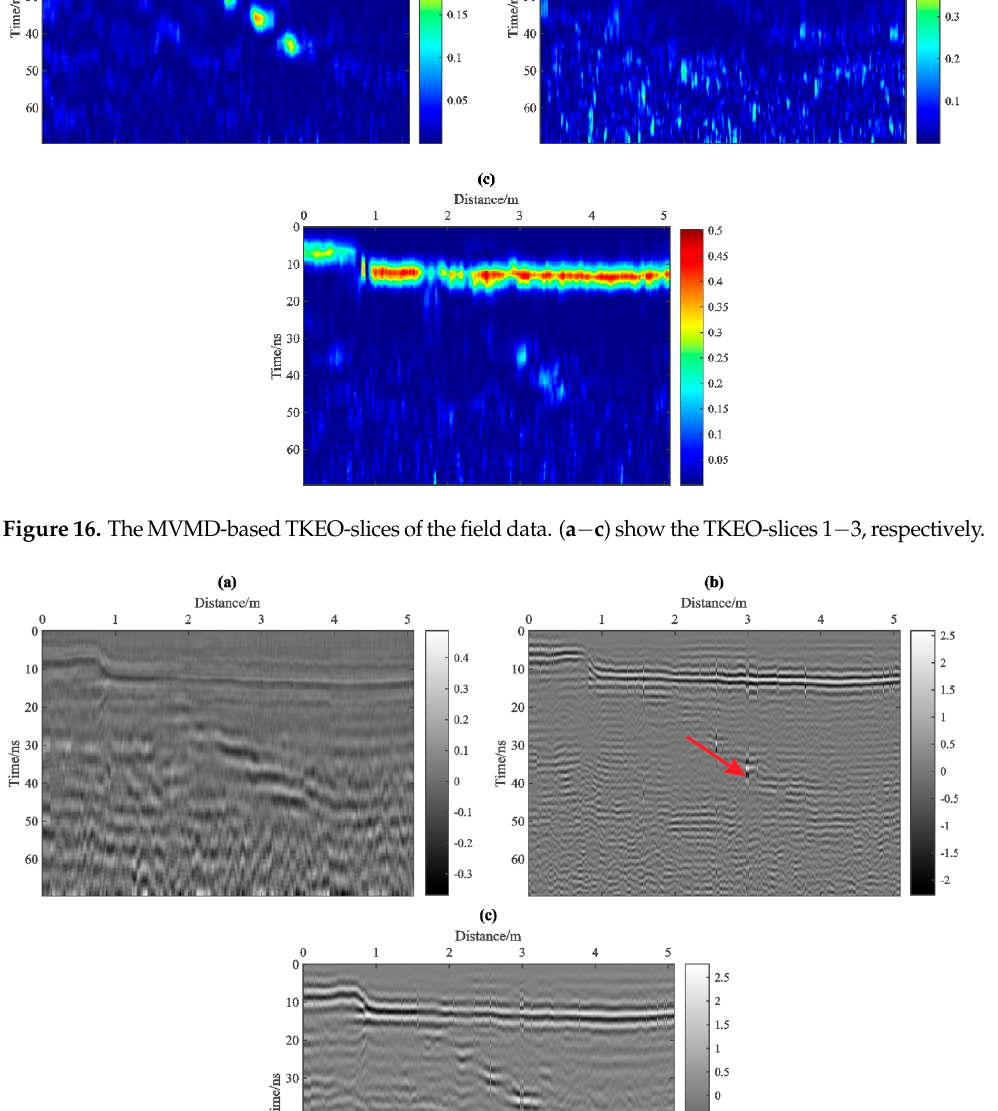
Figure 17. IMF-slices of the field data using VMD. ( a − c ) show the IMF-slices 1 − 3, respectively.